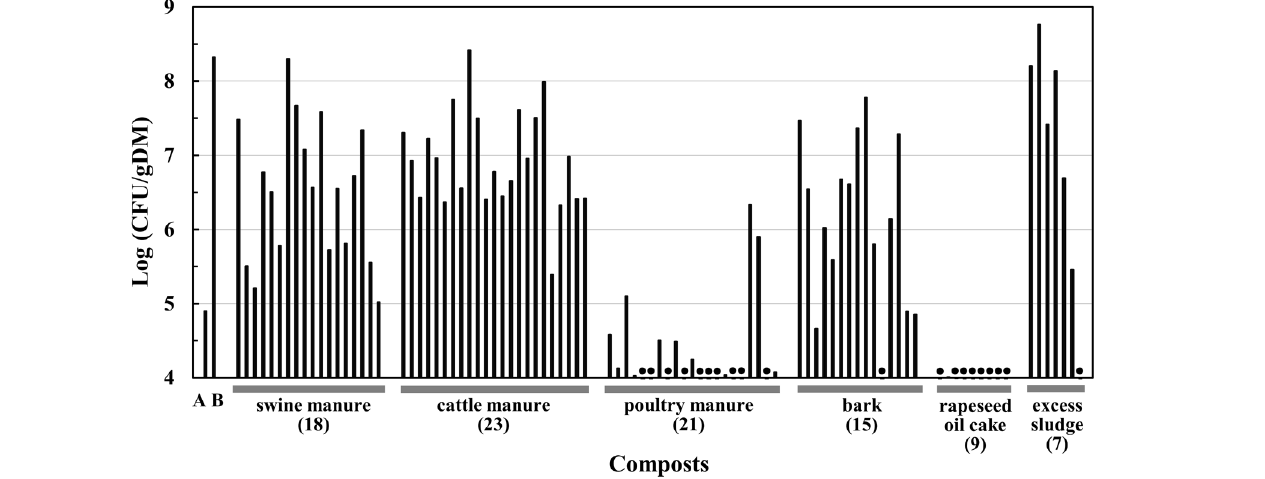
Figure 3. TAT bacterial concentrations in various composts. Columns A and B indicate the average TAT bacterial concentrations of the control treatment without the addition of TAT105 in swine manure composting tests [14]. A and B represent the concentrations at the start and end of composting, respectively. The remaining columns show the concentrations of TAT bacteria in the composts examined in this study. Filled circles indicate values less than 10 4 CFU/g DM. The raw materials and number of the compost samples are shown on the horizontal